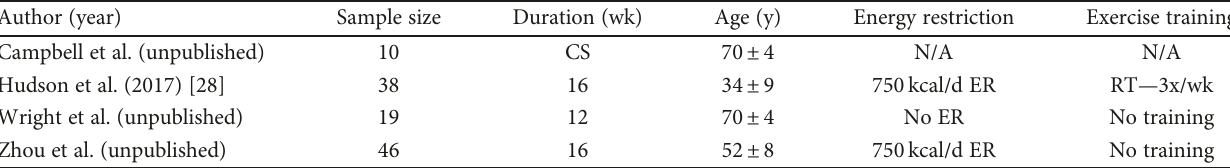
Table 1: Descriptions of the randomized controlled trials included in a secondary analysis on the relationship between intermuscular adipose tissue and indices of cardiometabolic health ¥